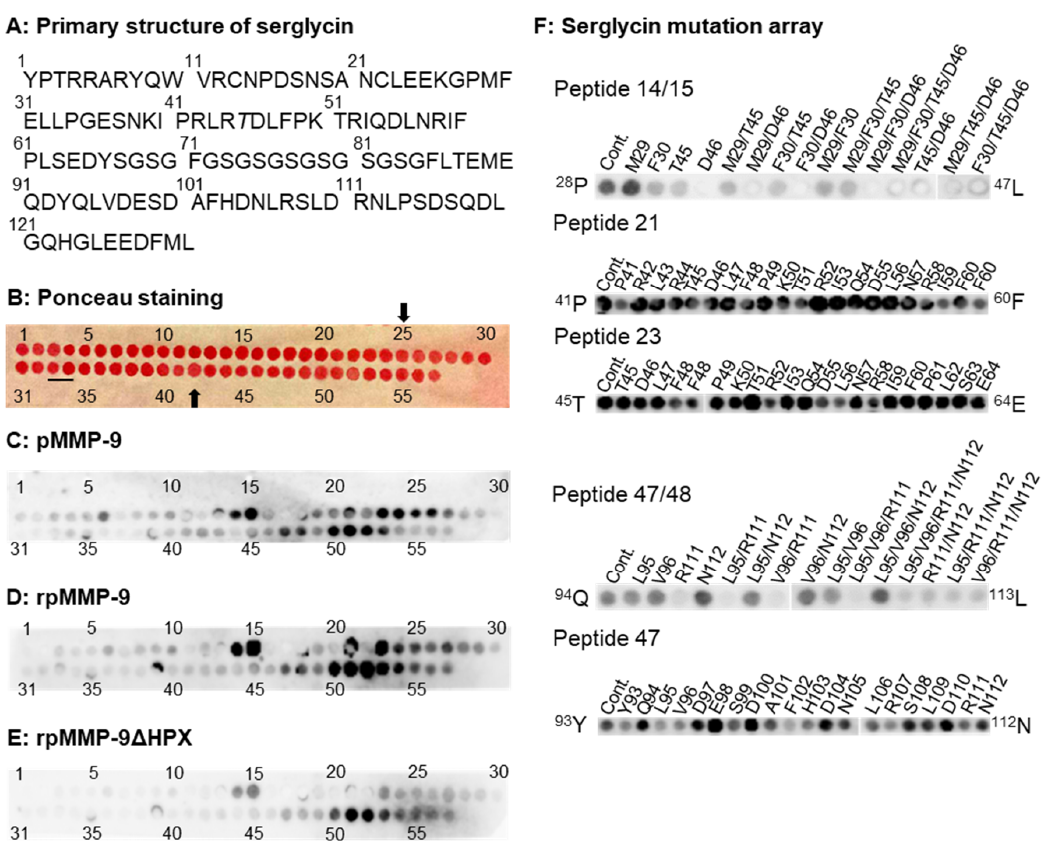
Figure 5. Binding of proMMP-9 variants to SG peptide arrays. ( A ) Primary structure of SG. ( B ) Ponceau staining of the 20-mer peptides bound on a cellulose membrane, where each peptide was obtained from a peptide walk along the entire SG sequence with an interval of two amino acids. For simplicity, every fifth peptide in the array is numbered, and the arrows show the starting and ending of peptides containing the GAG binding amino acids Ser-Gly (amino acids 67–84) in the center of the core protein; the two peptides that contain the entire 8 Ser-Gly repeats are underlined. ( C ) Binding of proMMP-9 purified from THP-1 cells (pMMP-9) to peptides in the SG core protein. ( D ) Binding of full-length recombinant proMMP-9 (rpMMP-9) to peptides in the serglycin core protein. ( E ) Binding of recombinant HPX truncated proMMP-9 (rpMMP-9ΔHPX) to peptides in the SG core protein. ( F ) Binding of pMMP-9 to a SG peptide arrays containing mutated amino acids based on the interpretation of the binding to peptides observed in Figure 5C,D. Two different arrays were performed where either (1) a combination of the predicted four possible amino acids from the binding pattern obtained in Figure 5C,D were mutated or (2) where every amino acid in the peptide was mutated as described in the Materials and Methods. Shown above each array are: (1) the number of the peptide in Figure 5C,D that was used for the mutation screen and (2) the name and number of the parent amino acid mutated. Shown also is the position of the N- and C-terminal amino acid of the 20-mer peptides. The un-mutated control peptide is labelled with Cont.